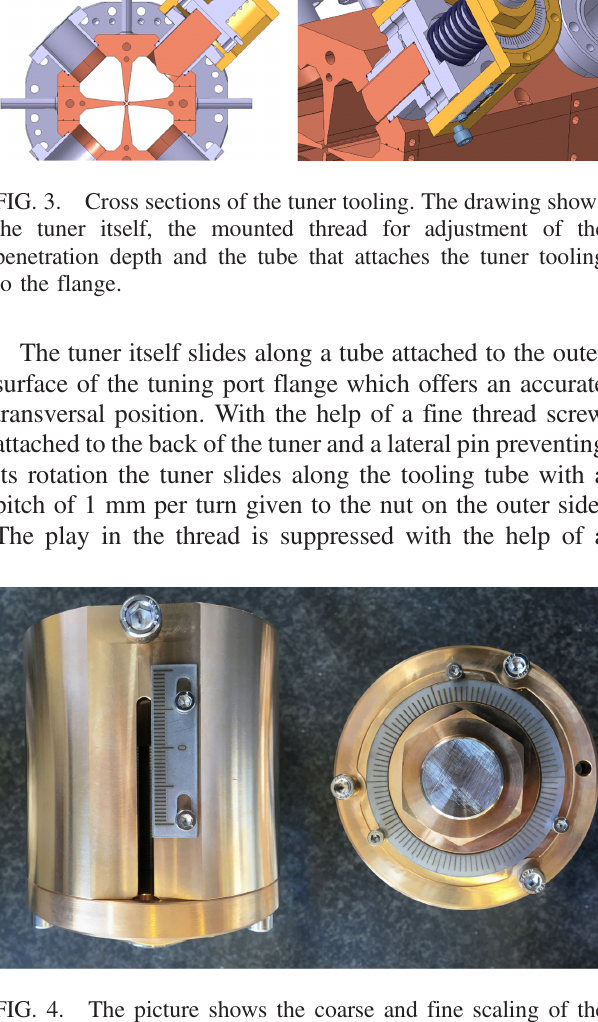
FIG. 4. The picture shows the coarse and fine scaling of the tuner tooling to adjust the penetration depth of the a tuner. The nut on the left side was used to vary the penetration depth of the